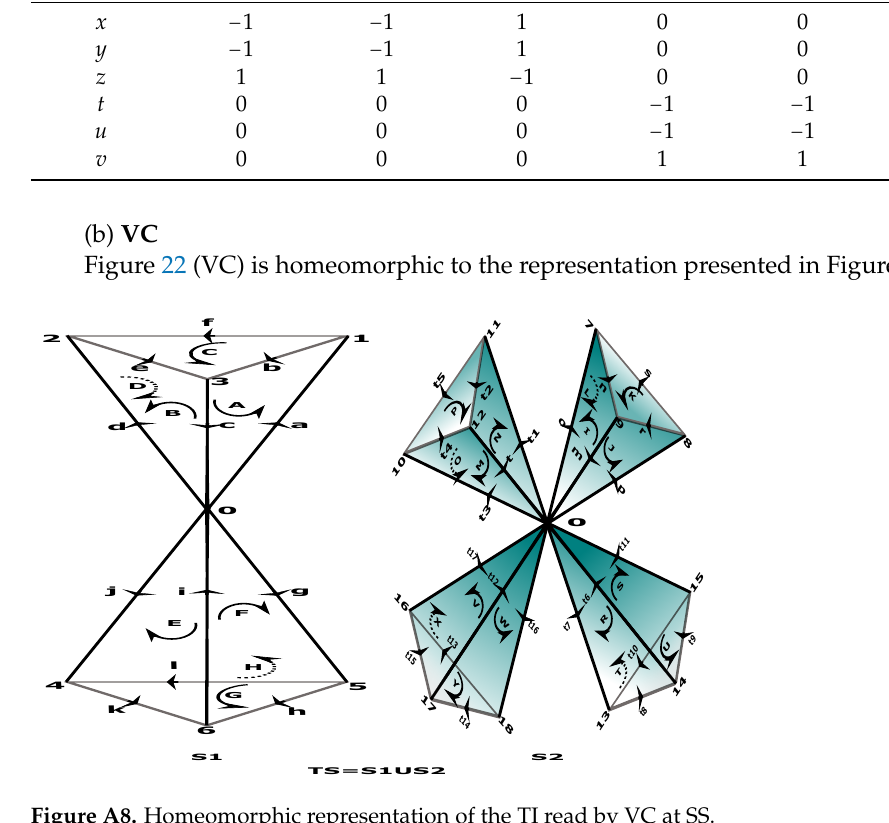
Figure A8. Homeomorphic representation of the TI read by VC at